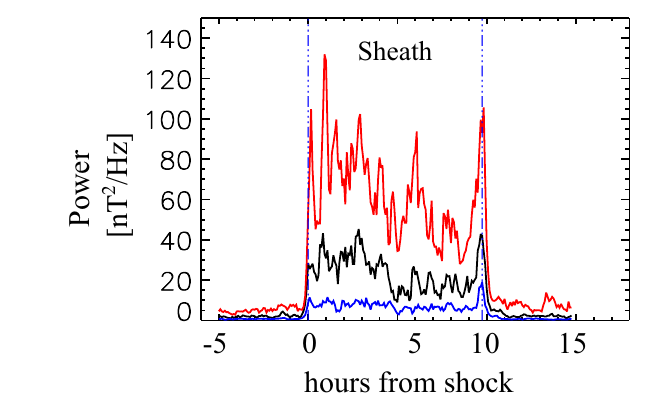
Fig. 19 ULF power of the north-south component of IMF in ICME sheaths. The black line is the median. The red and blue lines are upper and lower quartiles, respectively. The length of all sheaths is scaled to 10h (see Kilpua et al.